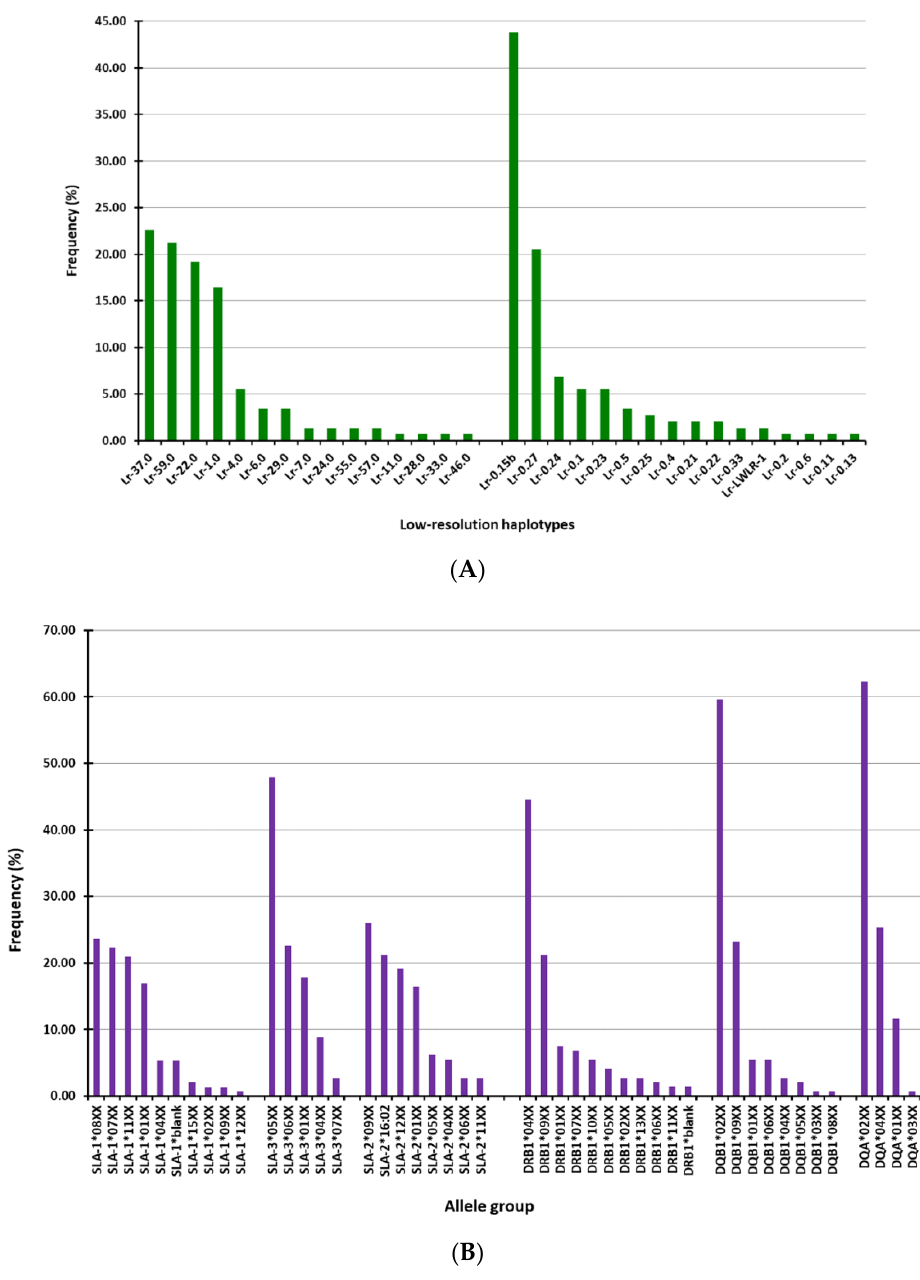
Figure 1. Frequencies of swine leukocyte antigen (SLA)-I and SLA-II allele-groups and Low-resolution (Lr) haplotypes in the cohort of 73 studied pigs. ( A ) Allele-groups at three SLA class I loci (SLA-1, SLA-2, and SLA-3) and three SLA class II loci (DRB-1, DQB-1, DQA). ( B ) SLA-I and SLA-II Lr-haplotypes (Table